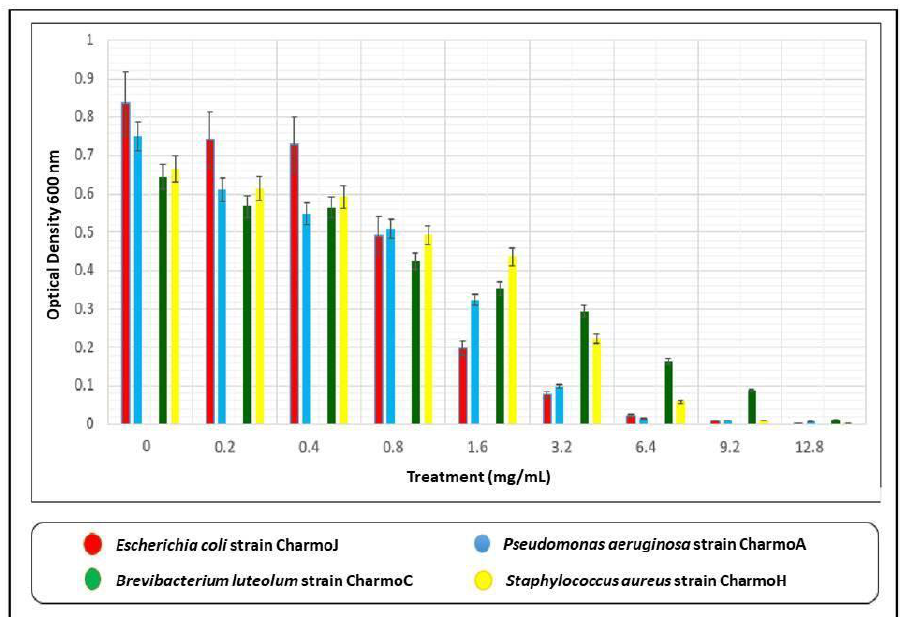
Figure 9. Effect of different concentrations of biologically synthesized Ag NPs on the growth of bacteria. Present data represent the mean values from three replicates of Ag NPs synthesis using GT aqueous extract.